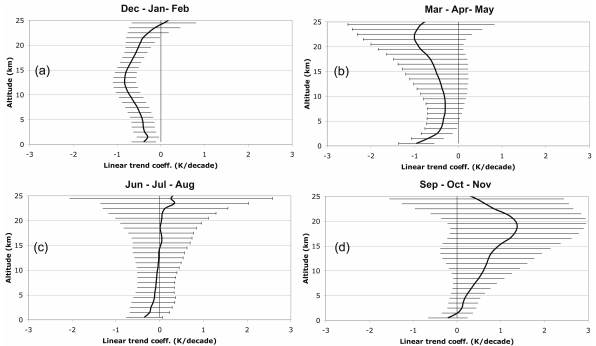
Fig. 6. Seasonal linear trends profiles at Dumont d’Urville, as de- rived from the AMOUNTS model by averaging the three corre- sponding monthly mean temperatures for (a) summer, (b) autumn, (c) winter and (d) spring. One-sigma uncertainty estimations are